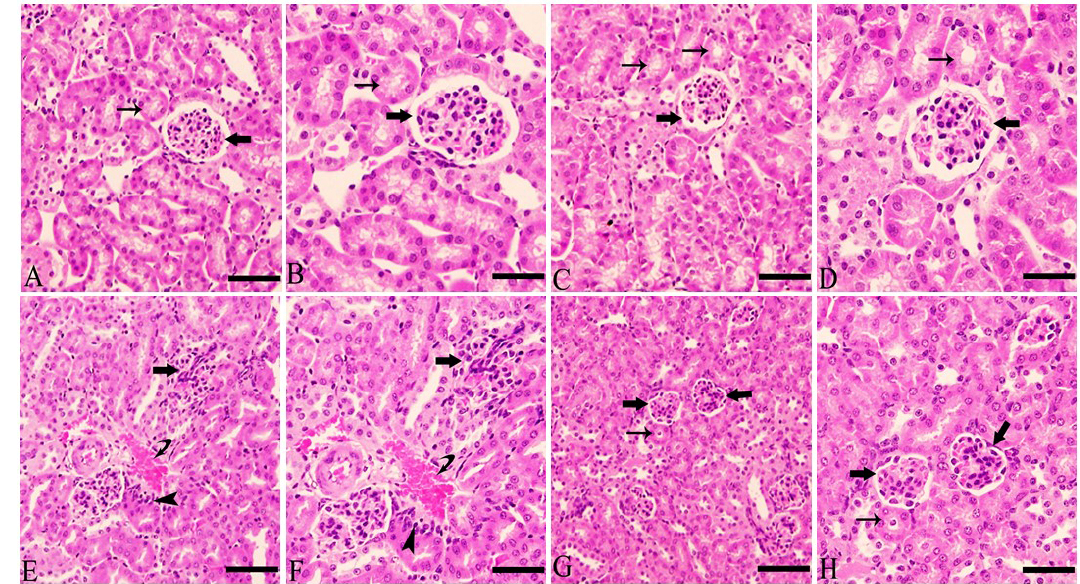
Figure 4. Photomicrographs of H&E-stained sections in the kidney of ( A , B ) Control and ( C , D ) A. graveolens -treated mice showing normal glomeruli (thick arrow) and renal tubules (thin arrow), ( E , F ) nicotine-exposed newborns showing inflammatory cells (arrowhead) and hemorrhage (curved arrow) and ( G , H ) nicotine-exposed newborns treated with A. graveolens showing ameliorated kidney structure. [Scale bar = 50 µ m ( A , C , E , G ) and 200 µ m ( B , D , F , H )].